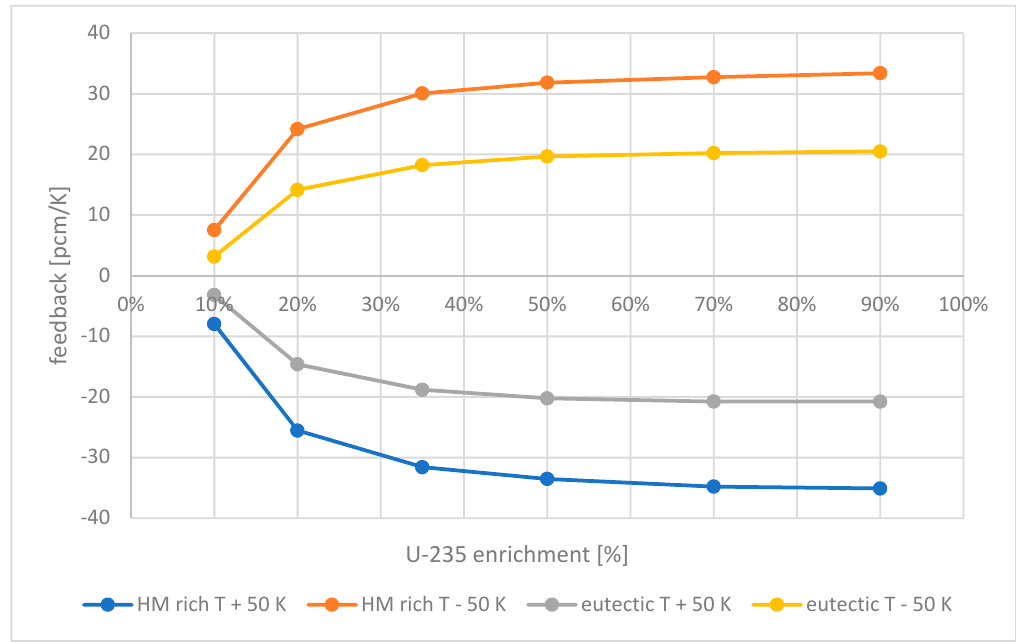
Figure 8. 2-D system thermal feedback effects (salt density and fuel temperature) for the eutectic and the heavy metal rich system depending on uranium enrichment (calculated through POLARIS).